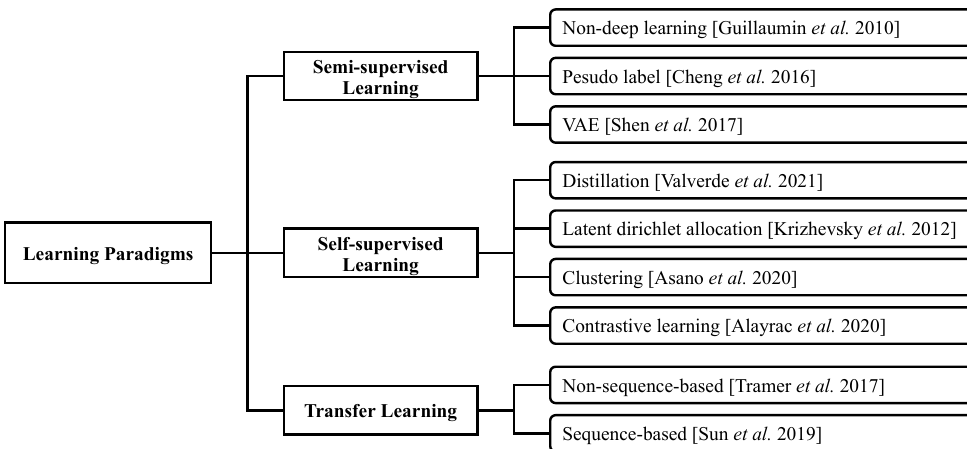
Figure 3. Multimodal learning